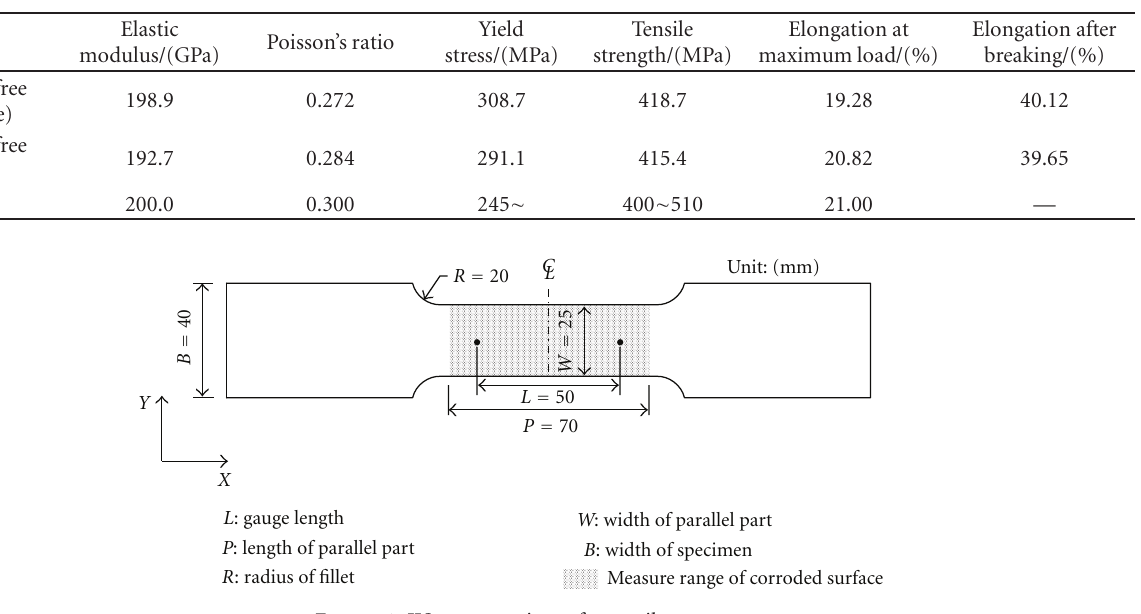
Figure 1: JIS no. 5 specimen for tensile test.